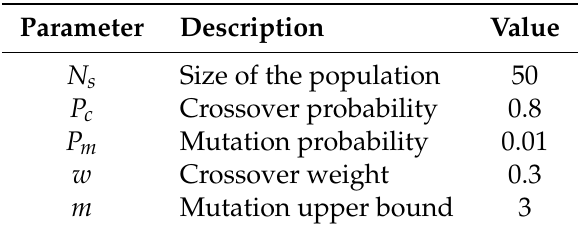
Table 1. Description and values of the parameters used in the